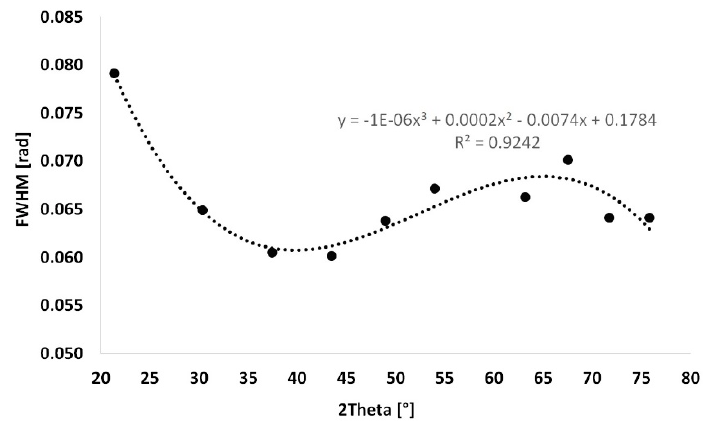
Figure 2. Instrument extension of LaB 6 .